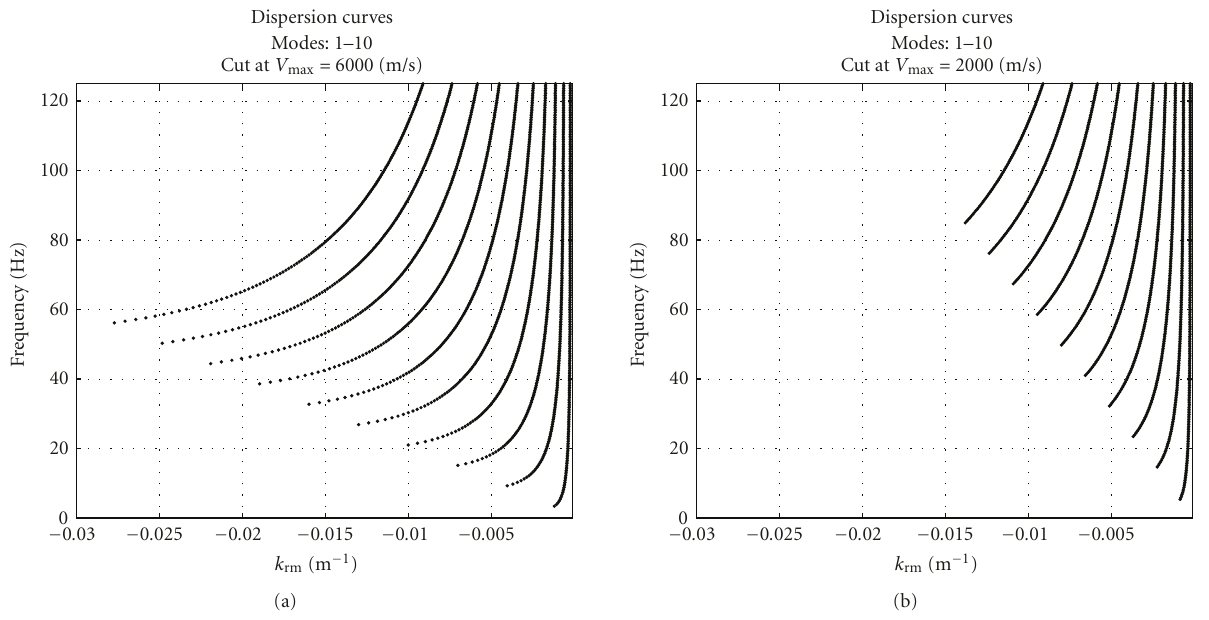
Figure 6: Moctesuma’ s dispersion curves no. 1 to 10 in frequency-wavenumber domain after V ref velocity correction (in plot, the mode number increases from (b) to (a)). Wavenumbers in (a) correspond to all propagating modes (water and seabed), and these in (b) plot correspond only to modes propagating in the water column.